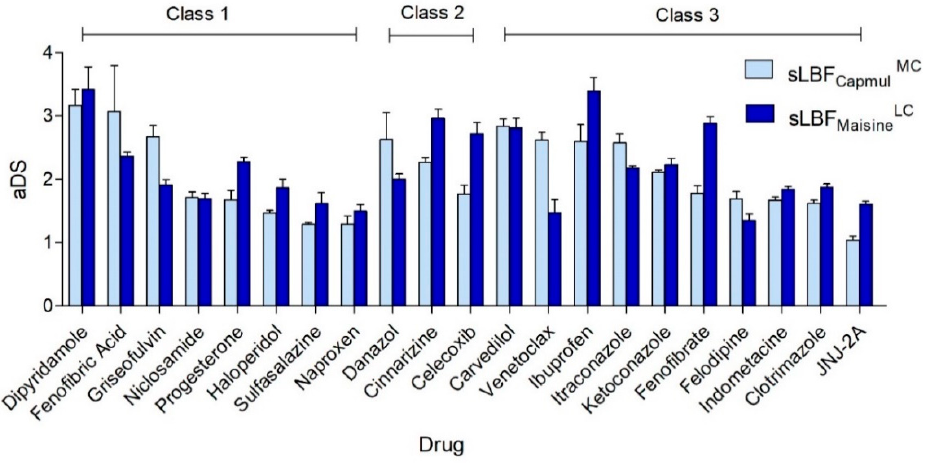
Figure 2. Apparent degree of supersaturation (aDS) ratios achieved for the dataset in both sLBF CapmulMC and sLBF MaisineLC . No clear aDS trend was elucidated in terms of the glass-forming ability (GFA) classification (as grouped). Details and definitions of the abbreviations are given in the text.